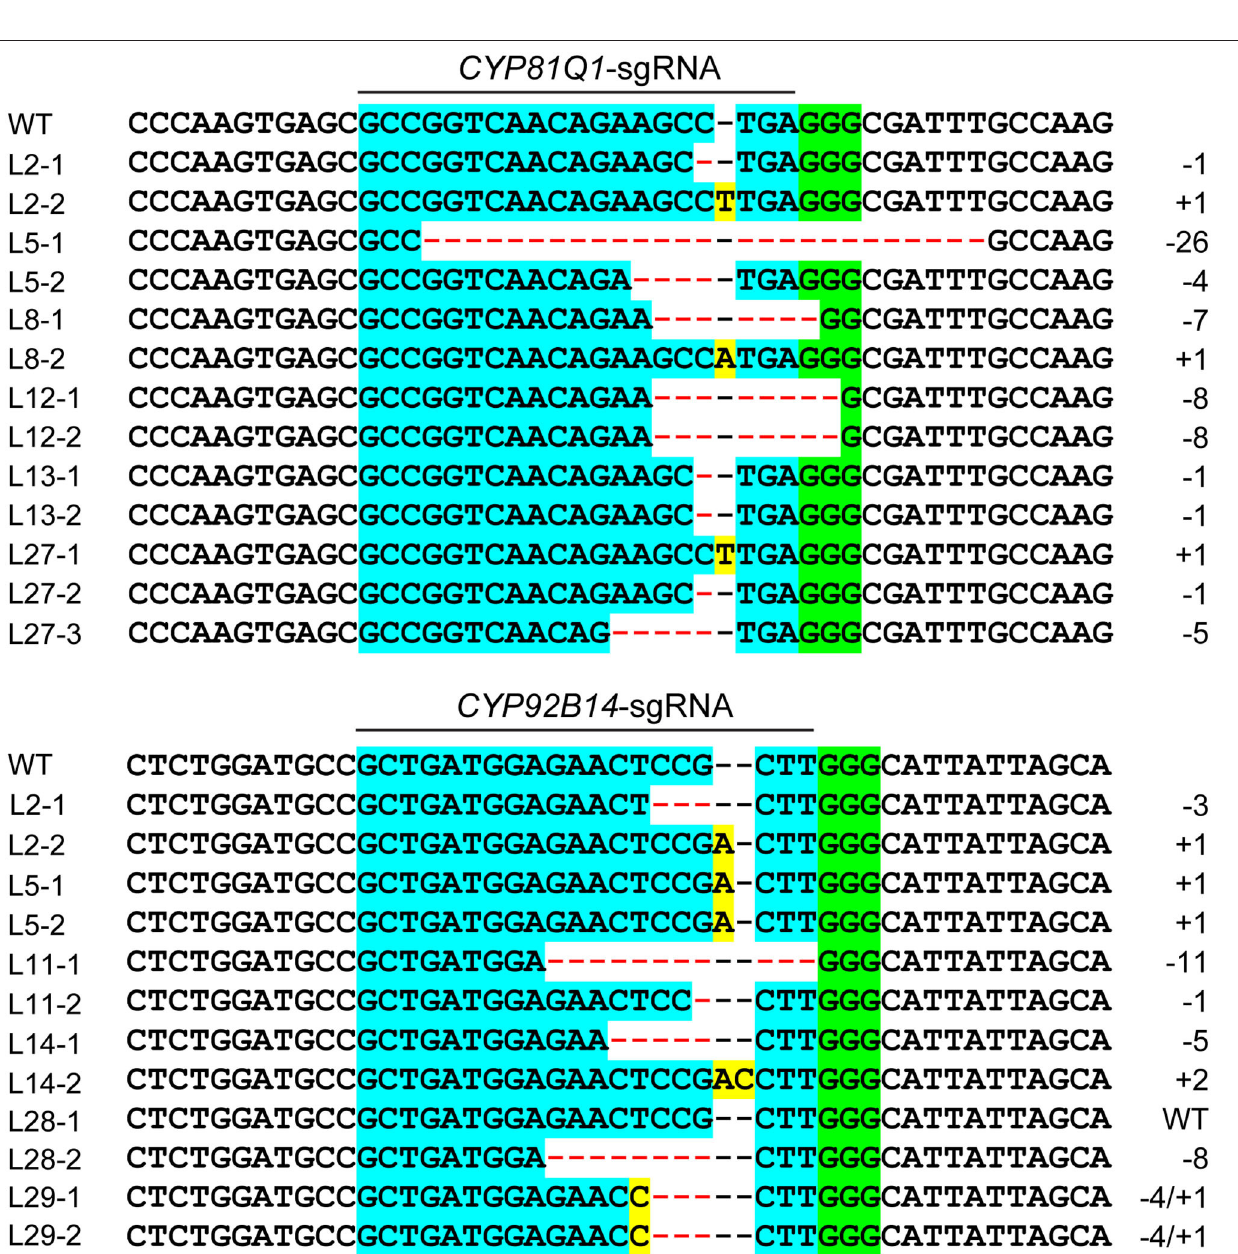
FIGURE 4 | Sequence analysis of CRISPR/Cas9-triggered targeted mutations in CYP81Q1 and CYP92B14 . Representative sequence alignments of six transgenic hairy root lines from each gene were shown. The sgRNA targets are indicated with light blue background and the PAM motif (NGG) is indicated with green background. The insertion and deletion of nucleotides are indicated with yellow background and red dashes, respectively. Mutation type insertion ( + ), deletion (–), and size are provided on the panel’s right side.